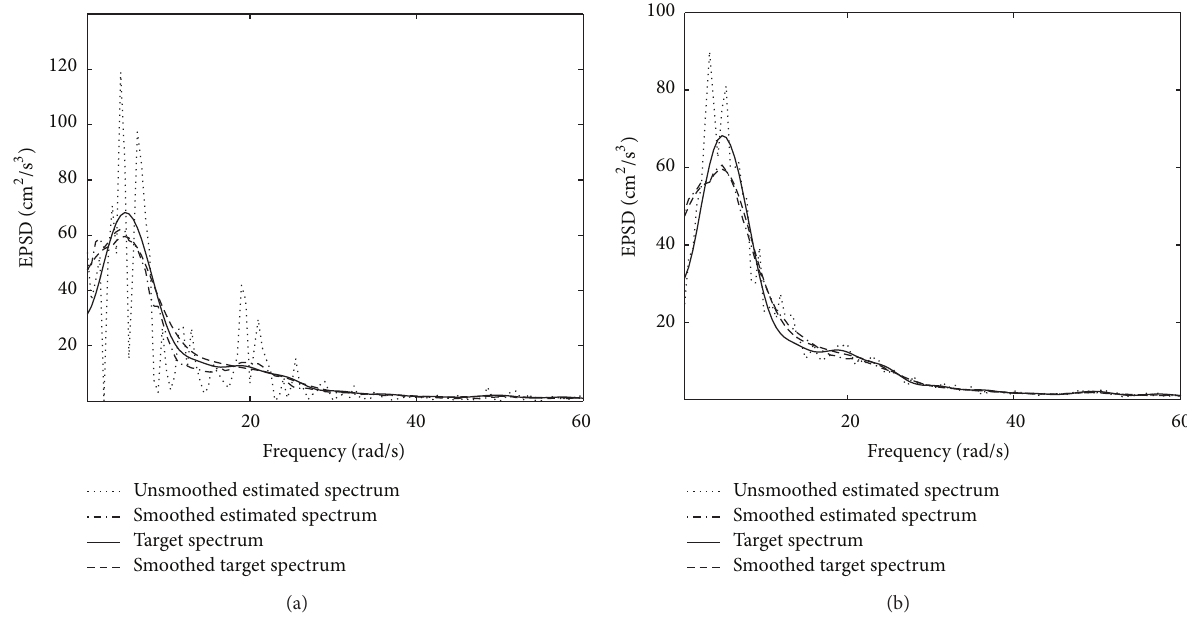
̂𝑆 (𝜔,𝑡) , 𝑆 0 (𝜔,𝑡) , and 𝑆 0 (𝜔,𝑡) ) at the time instant t = 2.0 s: (a) from one set of sample 11 11 11